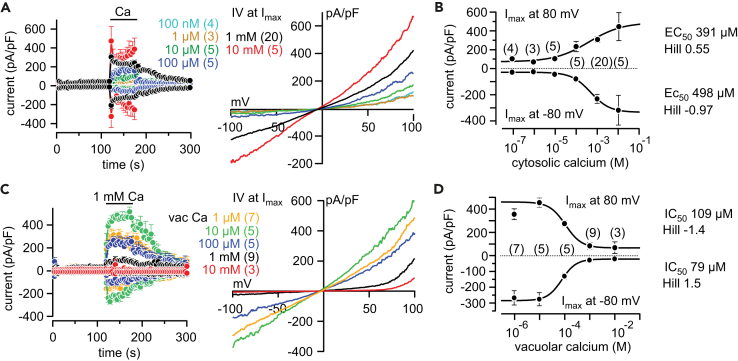
Concentration-Dependent Activation of Yeast Vacuolar TRPY1 by Cytosolic Ca2+ and Inhibition by Vacuolar Ca2+(A–D) Inward and outward currents at −80 and 80 mV, respectively, extracted from 200-ms ramps (0.5 Hz) spanning from 150 to −150 mV, Vh = 0 mV, plotted versus time (A and C, left), and corresponding IVs at maximum currents (Imax, A and C, right) activated by diverse cytosolic Ca2+ concentrations ([Ca2+]cyt, A and B) and 1 mM [Ca2+]cyt at the indicated vacuolar Ca2+ concentrations ([Ca2+]vac, vac Ca, corresponding to the [Ca2+] in the patch pipette, C and D) in isolated vacuoles from wild-type yeast. Application of Ca2+ is indicated by the bar. In (B), maximal inward currents (at −80 mV) and outward currents (at 80 mV) are plotted versus the [Ca2+]cyt concentration. The sigmoidal fits reveal EC50 values of 498 and 391 μM [Ca2+]cyt for half-maximal activation of the inward and outward currents (B), respectively. In (D), currents at −80 and 80 mV activated by 1 mM [Ca2+]cyt are plotted versus the [Ca2+]vac. The sigmoidal fits reveal half-maximal inhibition by [Ca2+]vac of 79 and 109 μM for the inward and outward currents (D), respectively. Currents are normalized to the size of the vacuole (pA/pF) and shown as means ± SEM (A–D) and means (IVs in A and C), with the number of measured cells indicated in brackets.See also Figures S1 and S2.